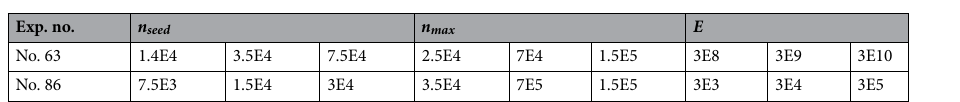
Table 5. Parameters n seed , n max and E for the laboratory experiment no. 63 and no. 86 by Ye et al.